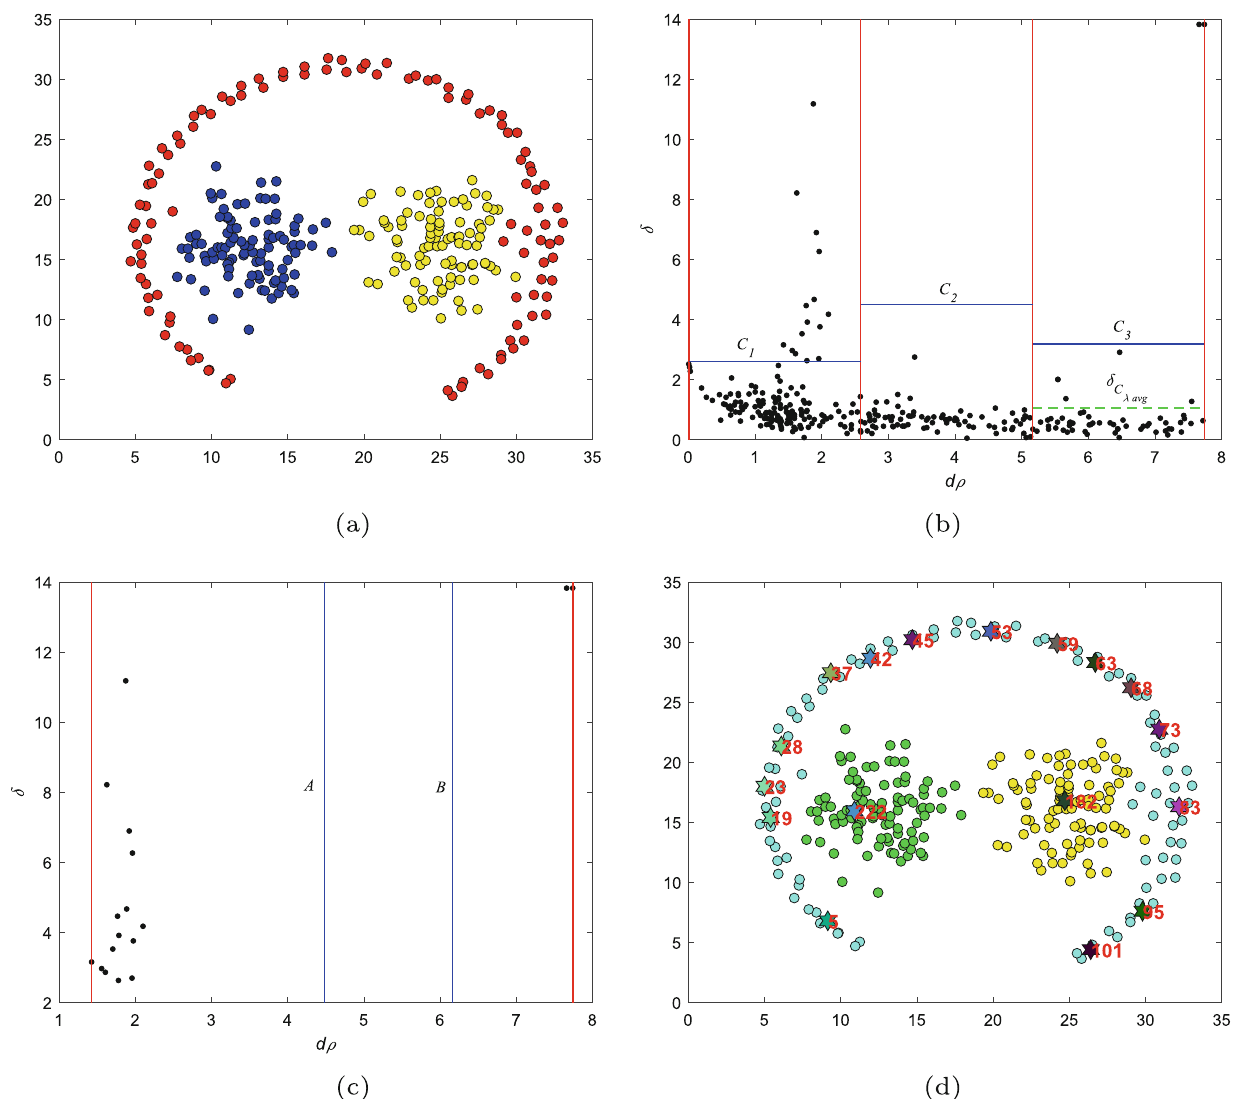
Fig.2 ClusteringresultsonPath-baseddatasetforAmDPCalgorithm. a Trueclusteringresult, b Decisiongraph, c Sub-clusteringcentersprocessing, d Automatic clustering